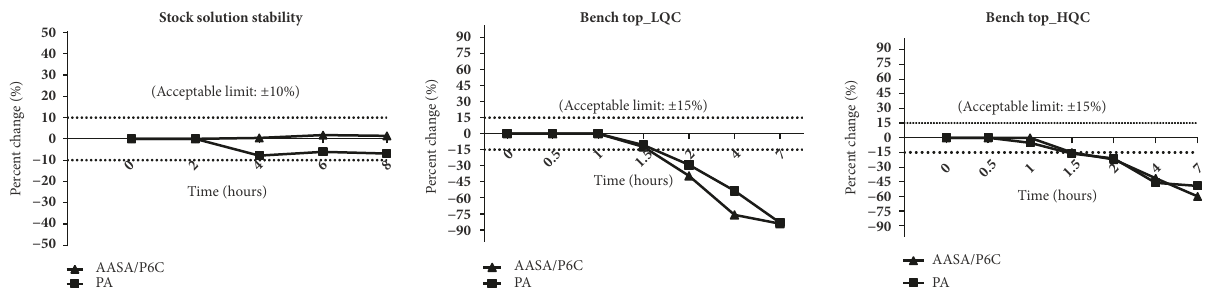
Figure 2: Stock solution stability studies and bench top stability studies of low quality controls (LQC) and high-quality controls (HQC) of 𝛼 -amino adipic semialdehyde, piperidine-6-carboxylic acid, and pipecolic acid. Table 2: Results of stock solution stability for alpha-amino adipic semialdehyde/piperidine-6-carboxylic acid and pipecolic acid. Stock solution